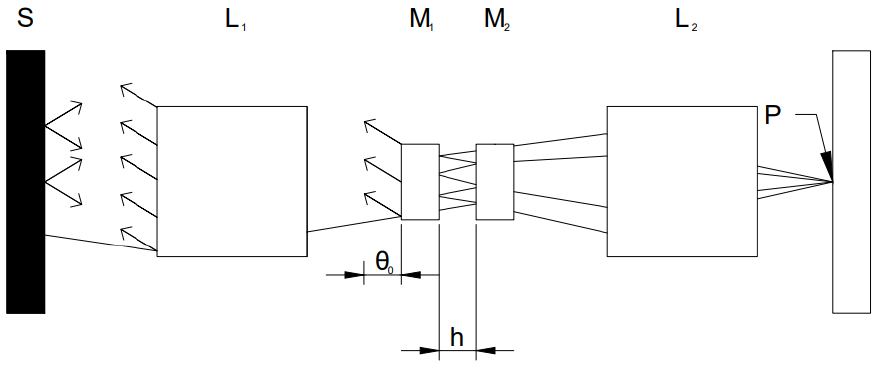
Figure 7. Schematic of the FP cavity [78]. S—source; L 1 , L 2 —lenses; M 1 , M 2 —transmissible mirrors; P—point of light on screen; h—distance between mirrors; θ —incidence angle of the wave.